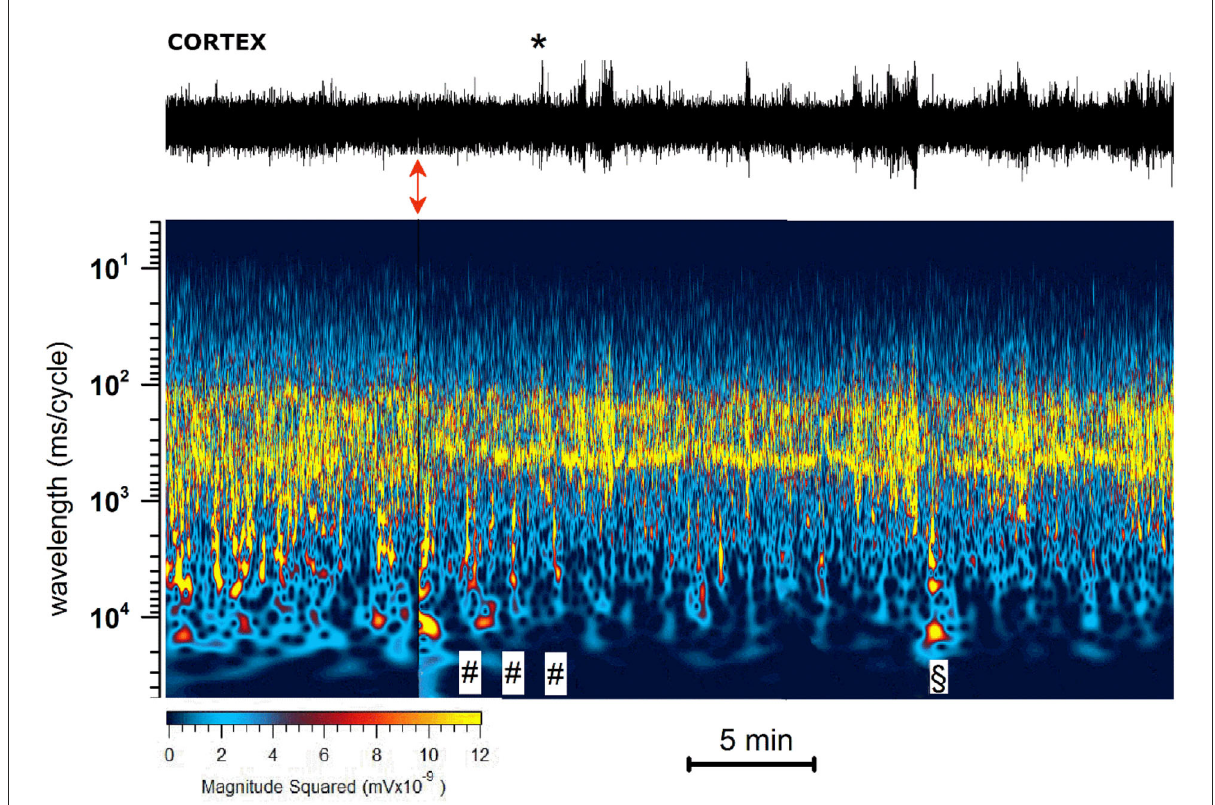
FIGURE4 Representative 40min recording of cortical EEG during JWH-073 administration and relative spectrogram. (Upper) Raw EEG with JWH-073 administration (red double headed arrow). Asterisk points to the first high amplitude event. (Bottom) Corresponding spectrogram correlating time (X) vs. wavelength (Y) and power (color scale). Wavelength ranges from 0.05 to 150Hz (Y axis, bottom to top). Color power scale (below X scale), with power magnitude increasing from left to right (smallest to highest values = darker to lighter colors). “#” symbols (bottom of the spectrogram), correspond to short-high energy episodes with frequency range 0.7–7Hz (not visible in the corresponding above EEG). “ § ” symbol (20min) points to an event with frequency range ∼ 2 to 30Hz followed by a short depression then by high energy/low frequency (0.05–7Hz) burst events. Similar sequelae were present in all